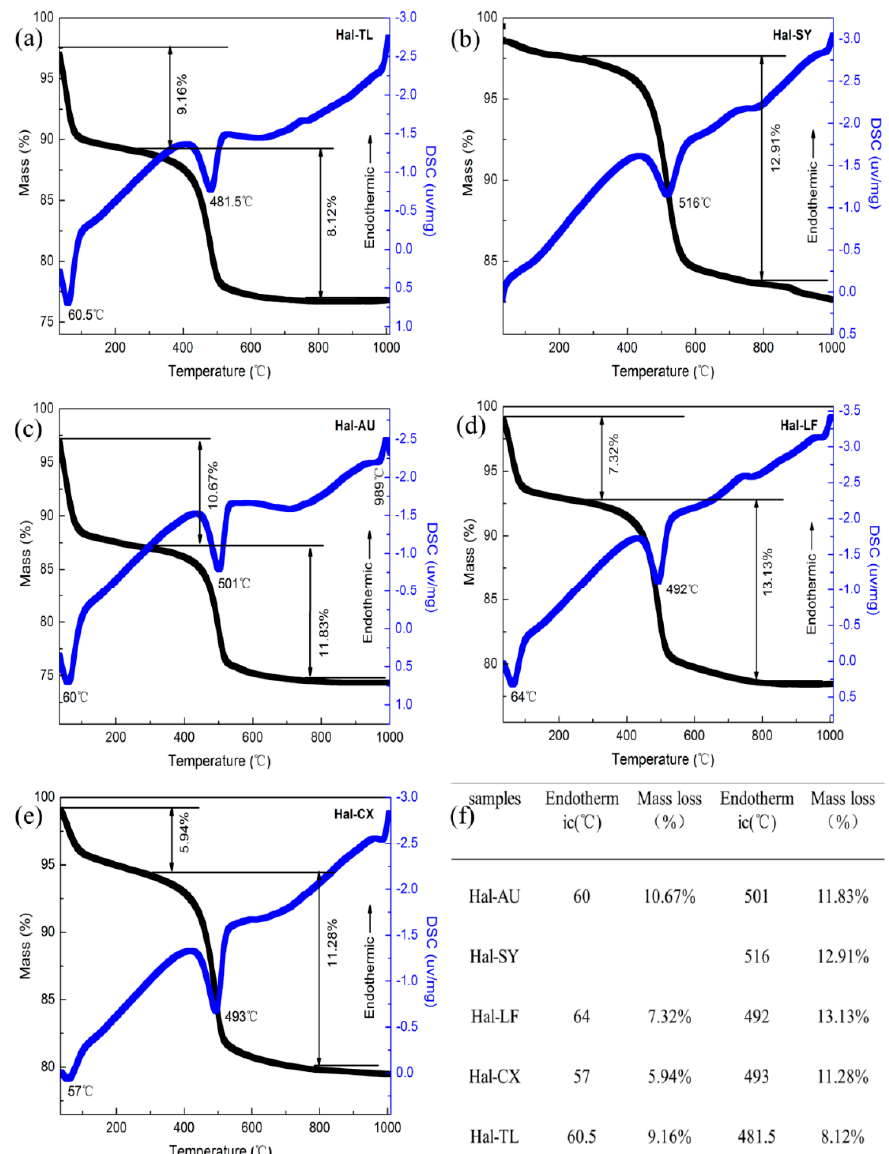
Figure 5. TG and DSC results for halloysite samples ( a ) Hal-TL; ( b ) Hal-SY; ( c ) Hal-AU; ( d ) Hal-LF and ( e ) Hal-CX; the table in ( f ) is the detailed parameters of each stages of thermal behaviors.